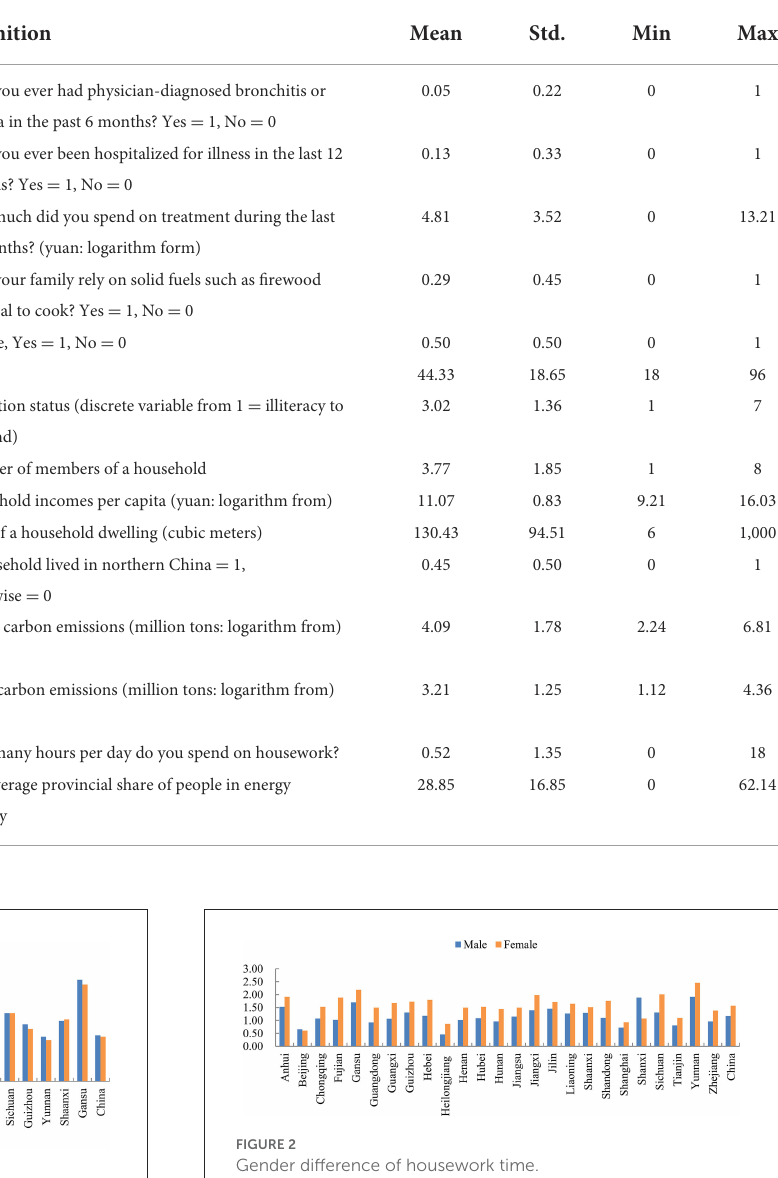
TABLE 1 Definitions of variables and summary statistics.